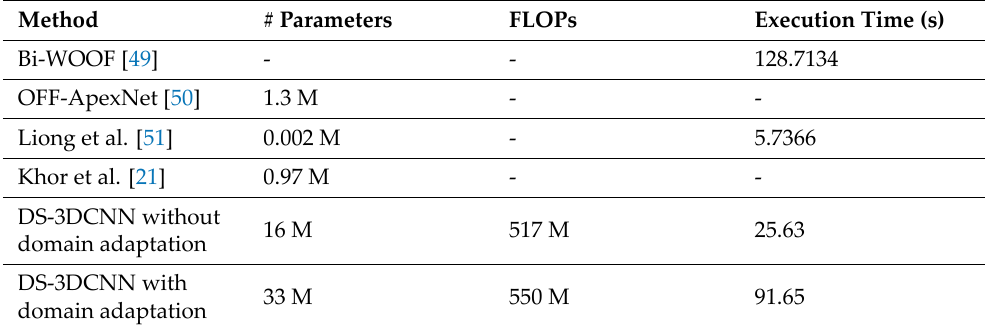
Table 3. Comparison of model complexity and run‑time analysis between the proposed models and state‑of‑the‑art